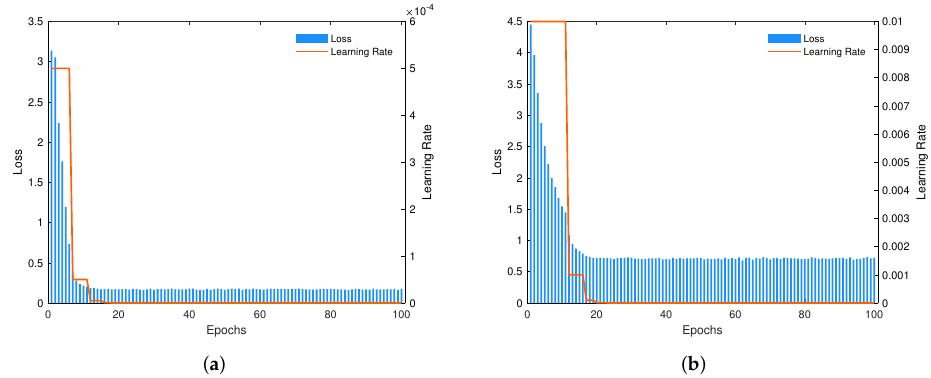
Figure 12. Learning rate and loss of spatial stream network and motion stream network. ( a ) UCF101. ( b )